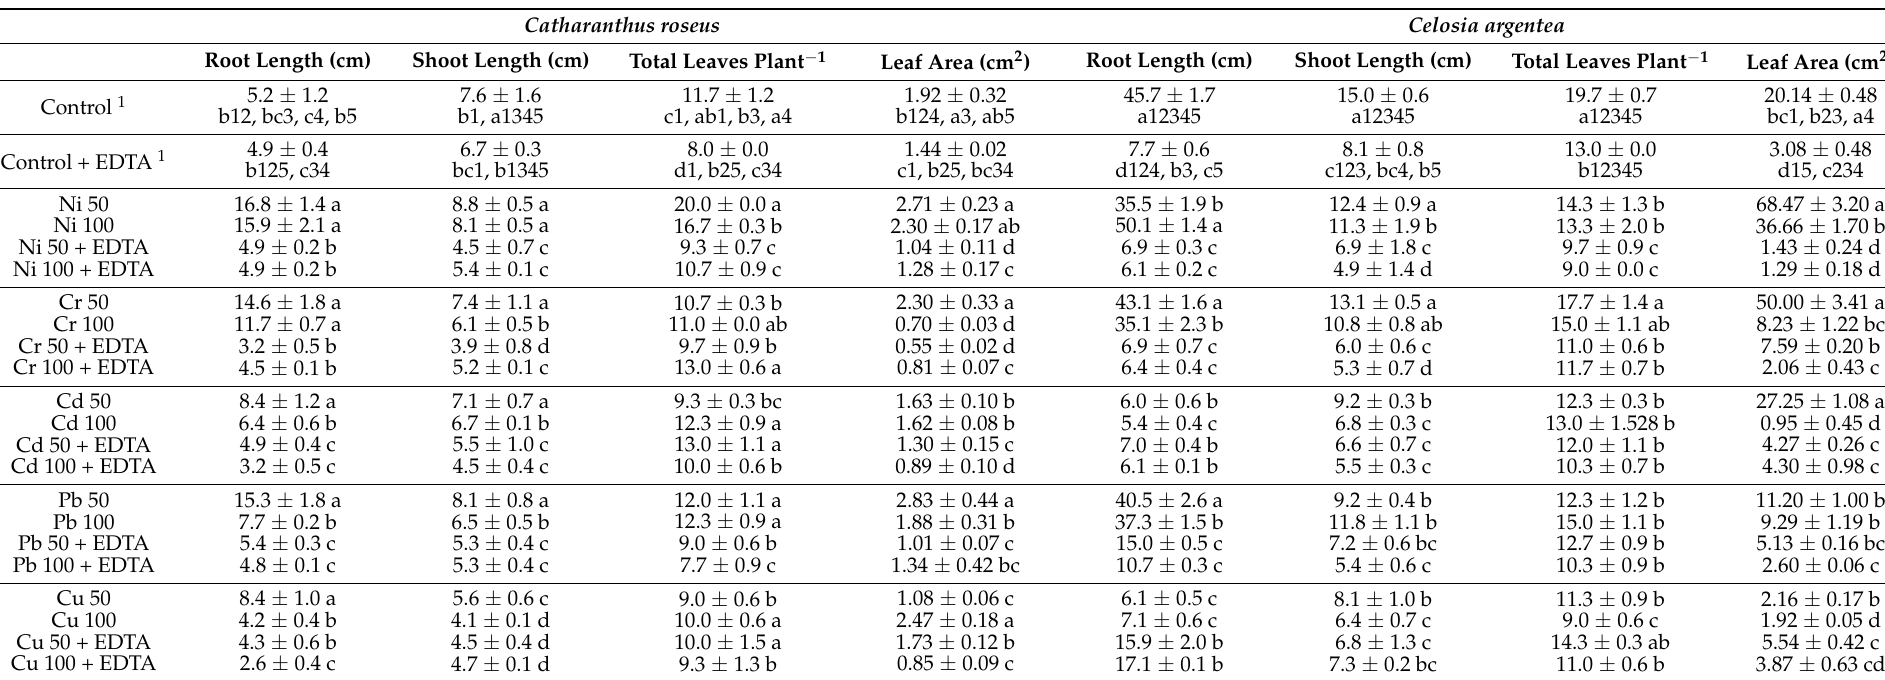
Table 1. Physiological parameters of Catharanthus roseus and Celosia argentea at different metal concentrations with and without EDTA. Catharanthus